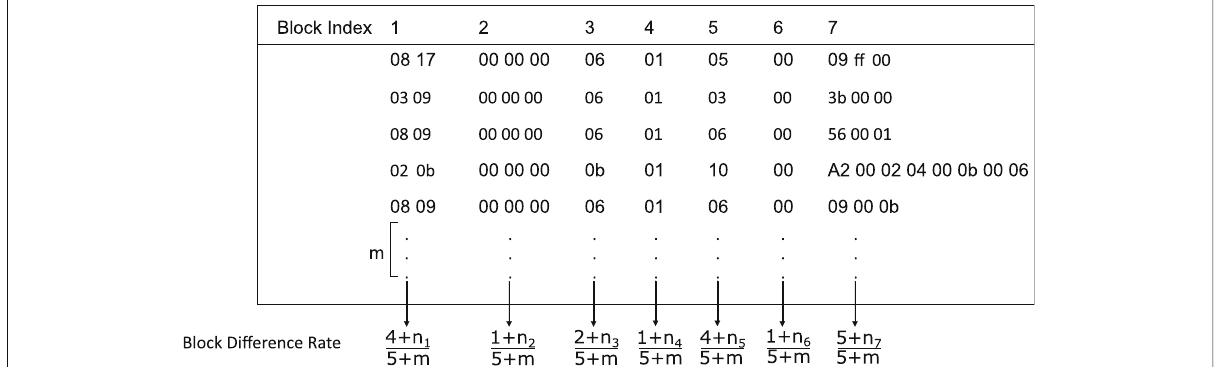
Fig. 8 The example of the block difference rate for total data. If the total amount of test data is 5+m, the block difference rate in the first column will . There are 4 + n 1 different values in the first be 4 + n 1 5 + m